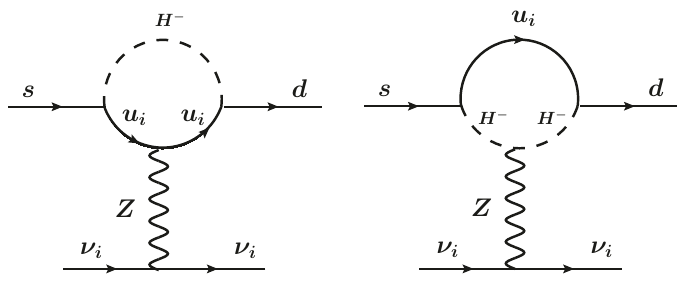
Figure 3 . H − induced Z -penguin contributions to s → dν ¯ ν in